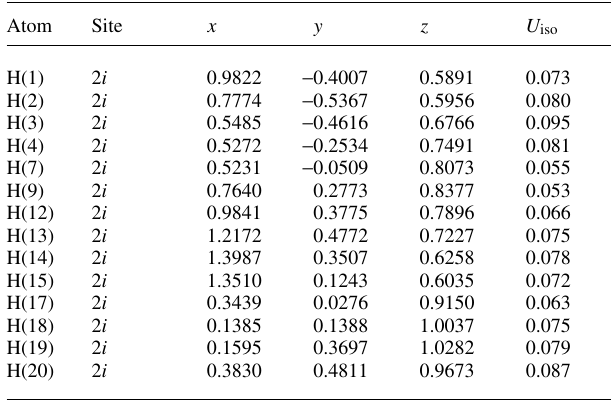
Table 2. Atomic coordinates and displacement parameters (in Å 2 )